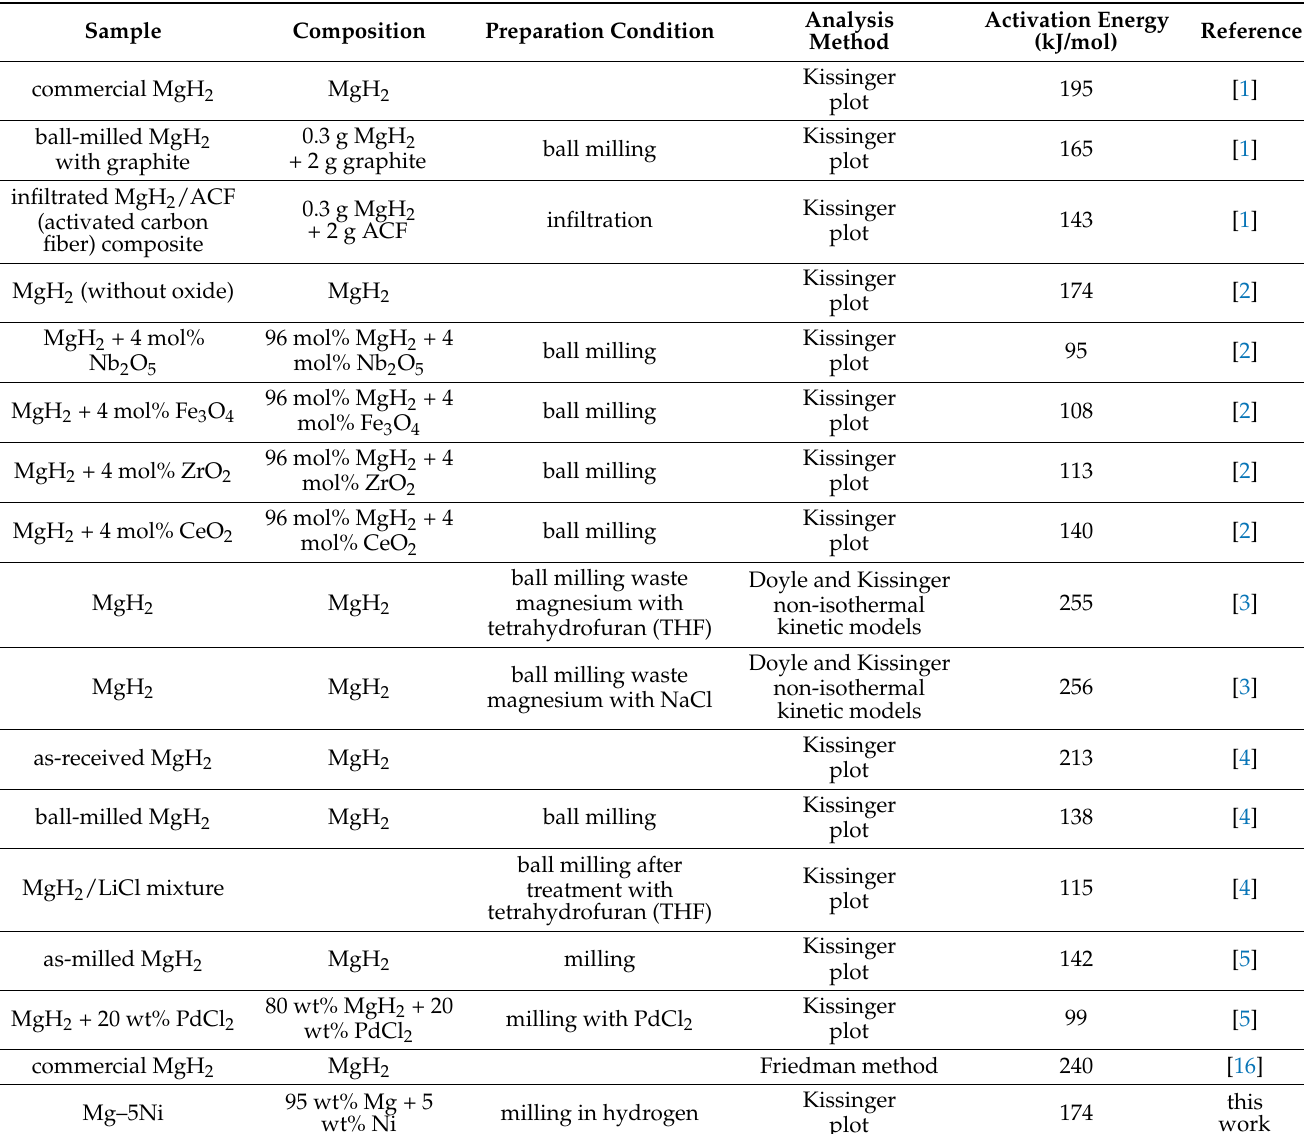
Table 3. Activation energies of reported Mg-based hydrogen storage